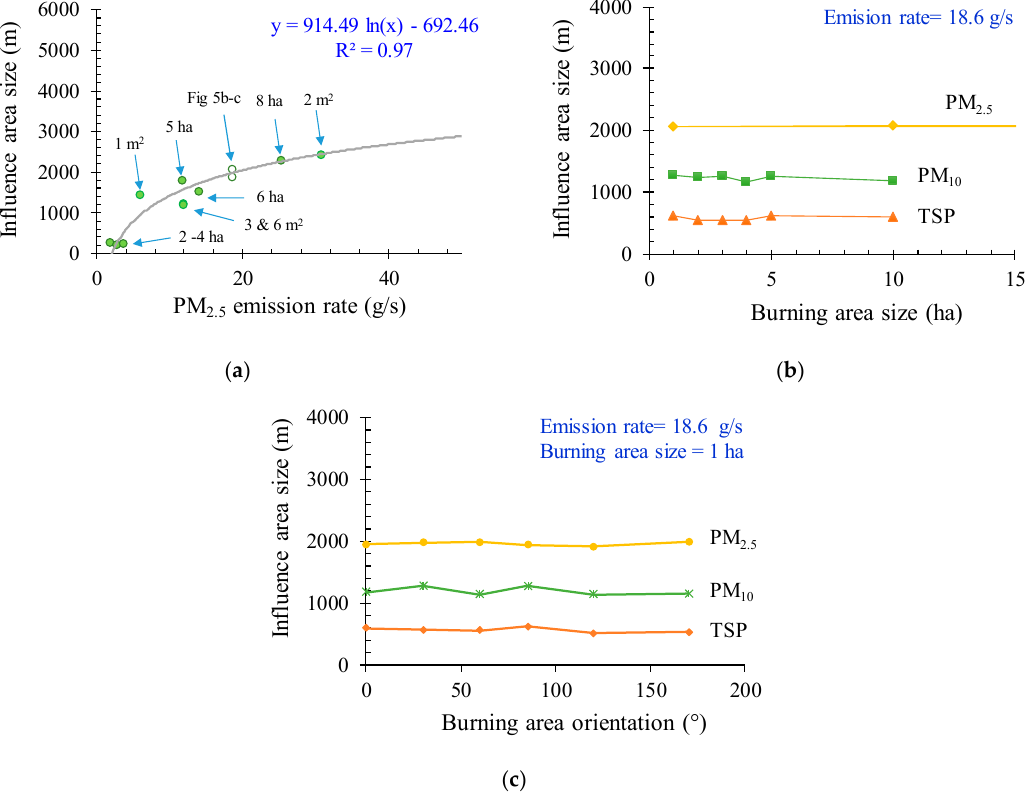
Figure 5. Size of the influence area generated by agricultural burning as function of: ( a ) emission rate considering different burning area sizes; ( b ) burning area keeping emission rate constant at 18.6 g/s; and ( c ) burning area orientation respect to north, keeping constant the emission rate at 18.6 g/s and the burning area at 1 ha.